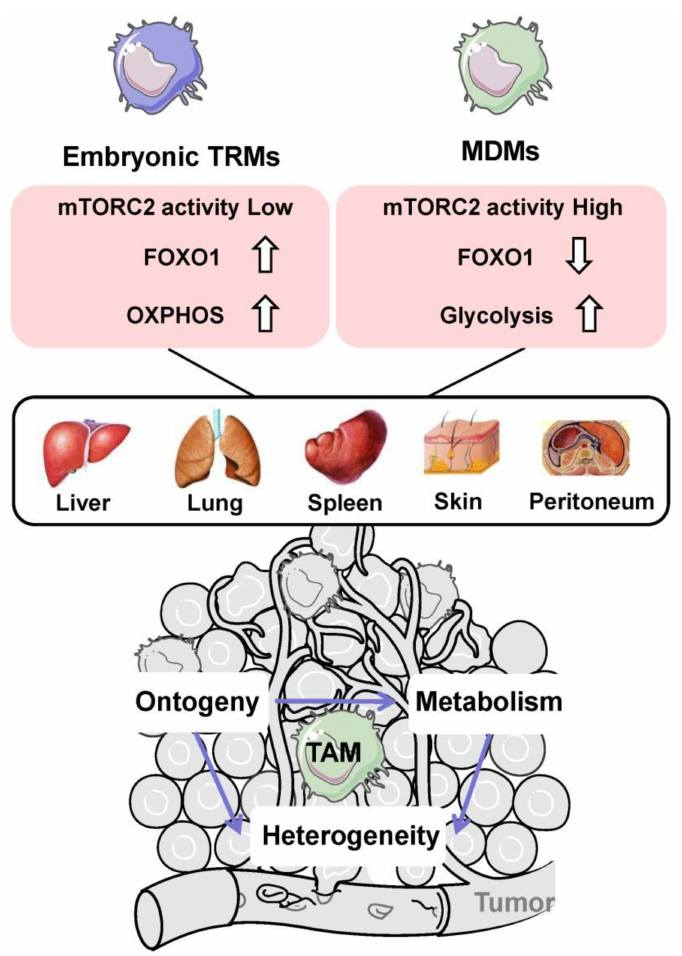
Figure 3. The metabolic regulation of TAMs’ ontogeny. Embryonic TRMs in the peritoneum dis- play decreased glycolysis and increased OXPHOS compared with monocyte-derived peritoneal macrophages due to mTORC2/FOXO1 axis. Higher FOXO1 expression is also observed in other TRMs (in the lung, spleen, skin, and liver) compared with MDMs, indicating this metabolic bias’s tissue universality. Embryonic TRMs and bone marrow MDMs constitute TAM pools in various tumor types. The metabolic imprints in TAMs from different origins may play an essential role in TAM heterogeneity. TRMs: tissue-resident macrophages; MDMs: monocyte-derived macrophages. TAMs: tumor-associated